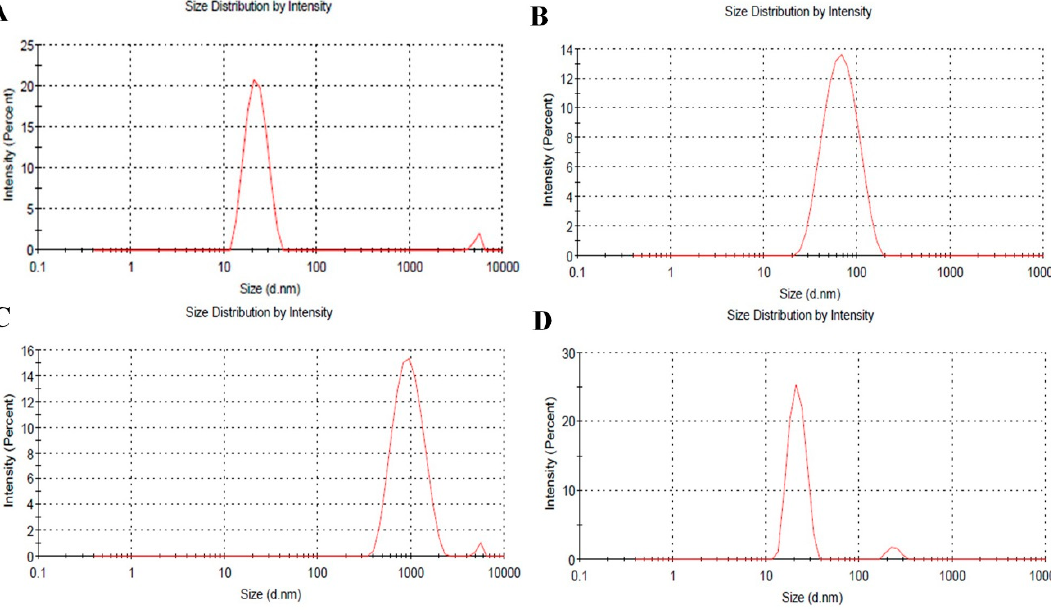
Figure 6. The size distribution of ( A ) only polyDOPA-AgNPs, and in the presence of ( B ) Cu 2+ ; ( C ) Pb 2+ , and ( D ) Cd 2+ ions (0.1 μ M).